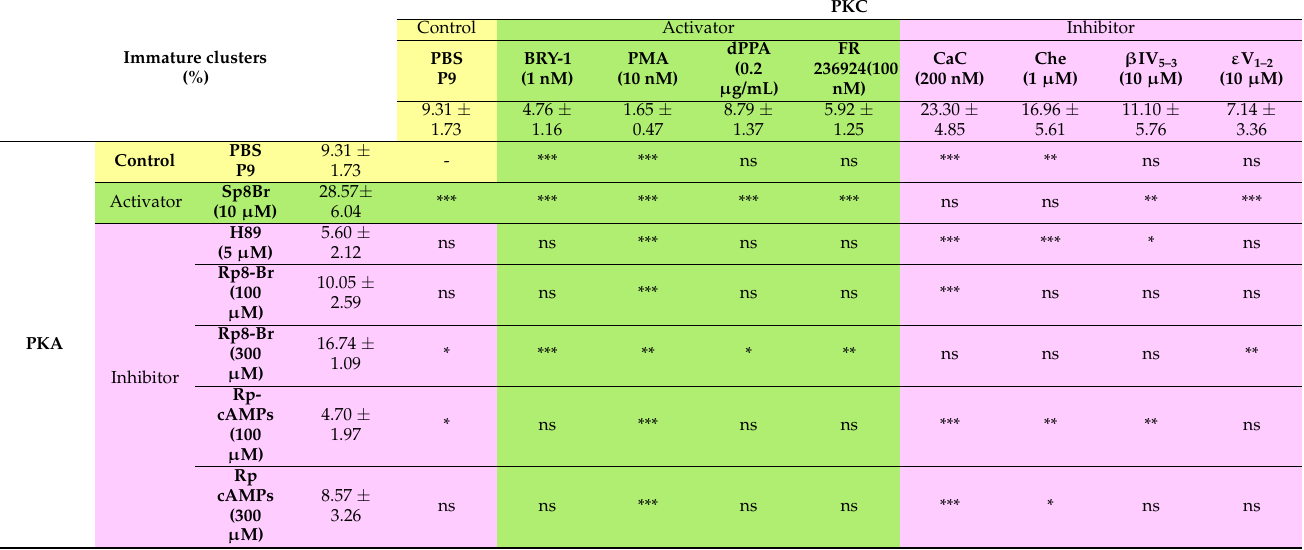
Table 3. Percentage of immature AChR postsynaptic clusters in P9